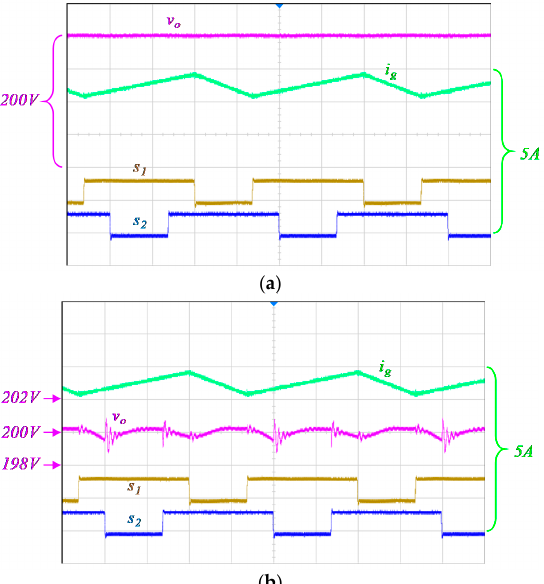
Figure 16. ( a ) The output voltage, input current, and firing signals when D = 0.6543 ( Vg ≈ 24 V) in the proposed strategy and ( b ) same signals with a zoom in the output voltage ripple.